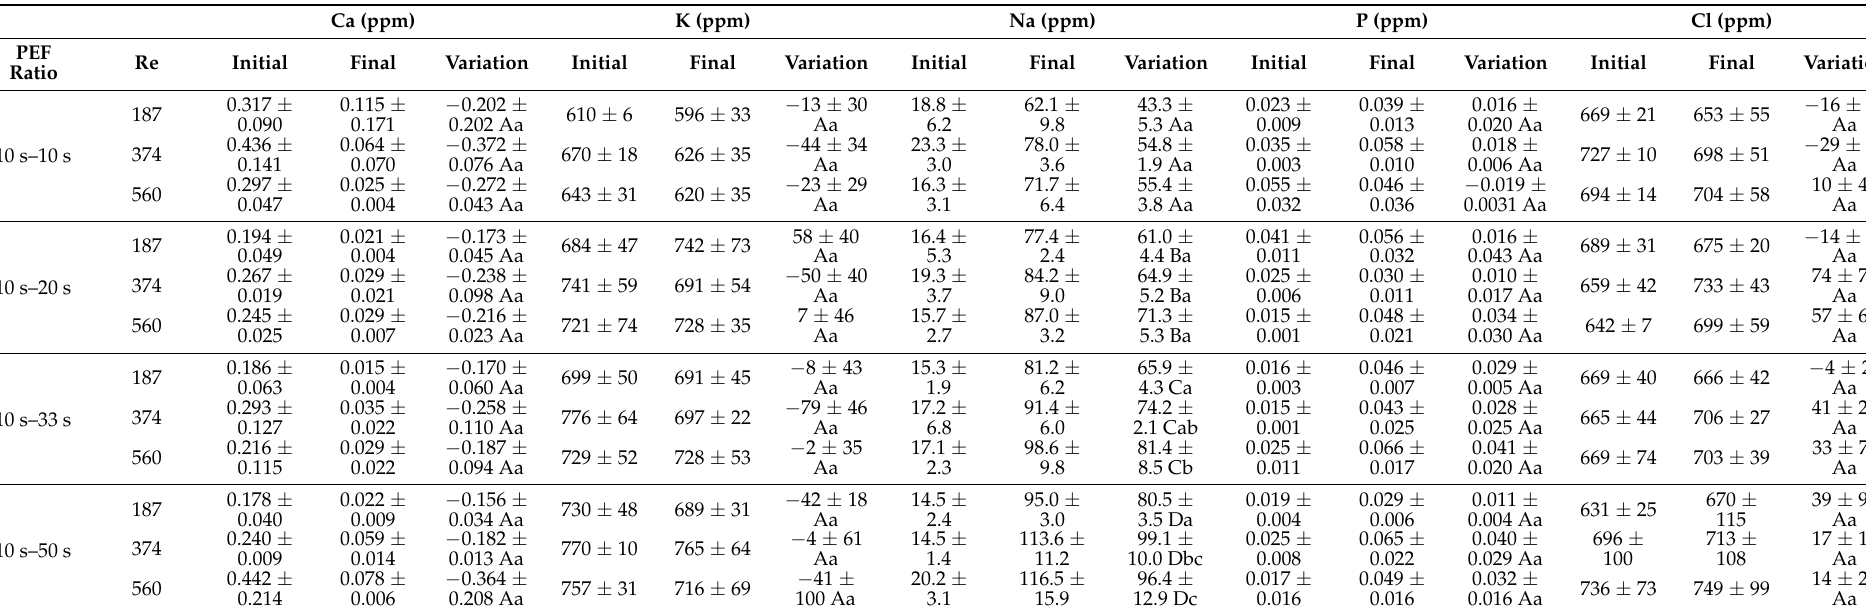
Table 3. Average mineral content of the KCl stream before and after EDBM depending on the Reynolds numbers and the pulse–pause durations of the PEF current modes (10 s–10 s, 10 s–20